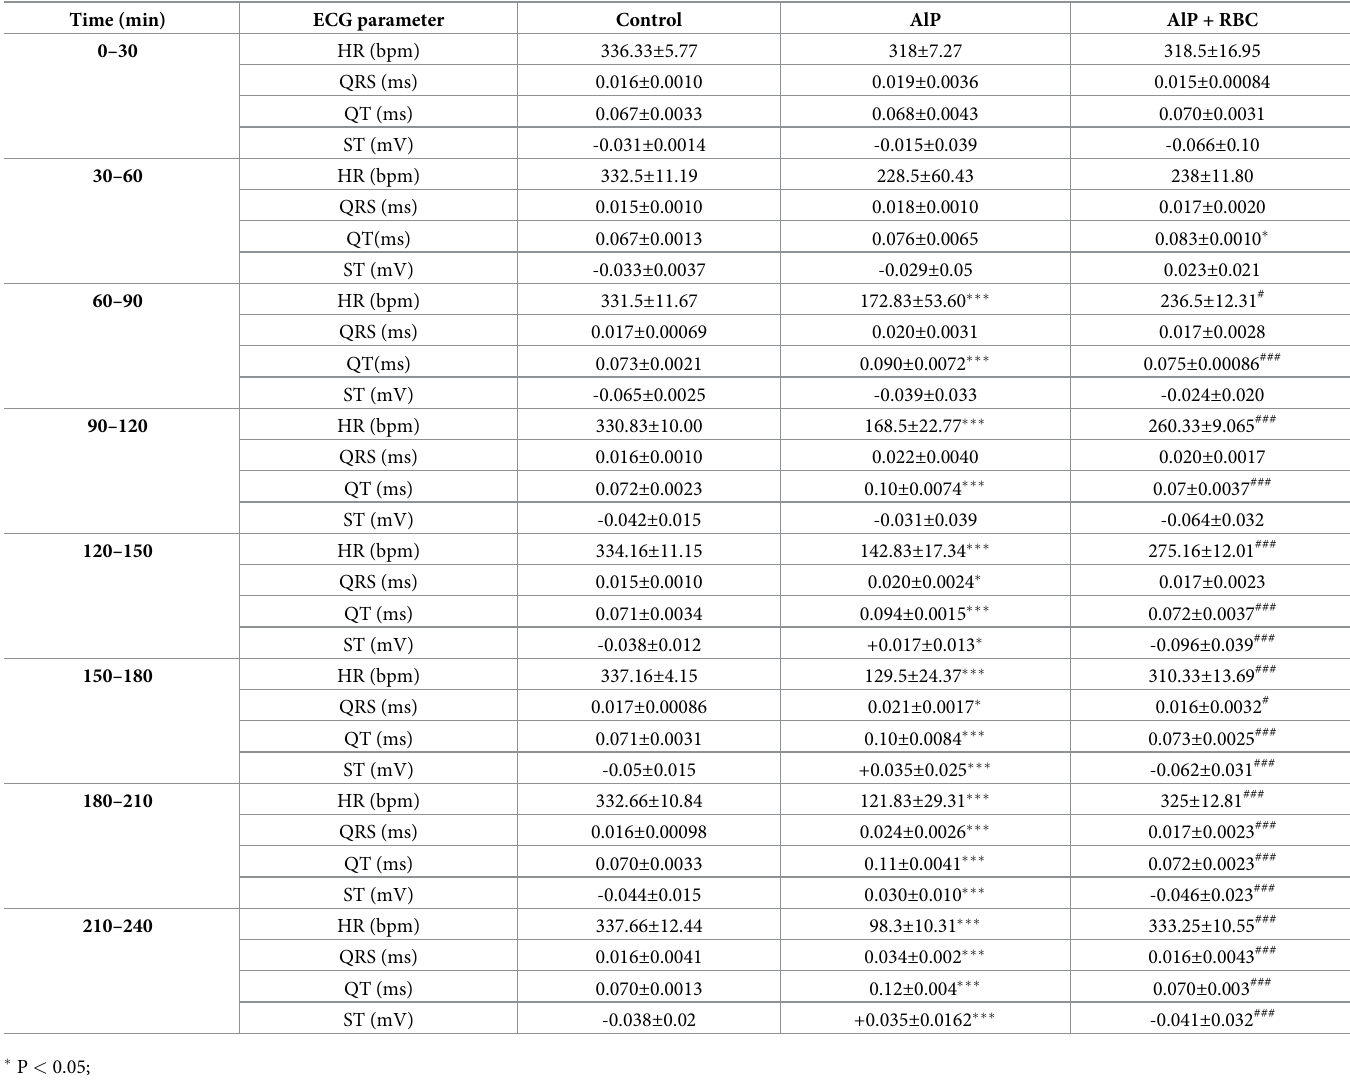
Table 1. Effects of transfusions of fresh packed red blood cells (RBC) on heart rate (HR), and ECG parameters in three experimental